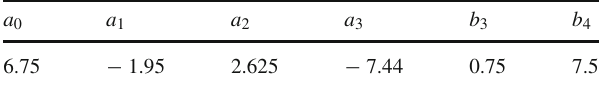
Table 1 Parameters of the Polyakov-loop